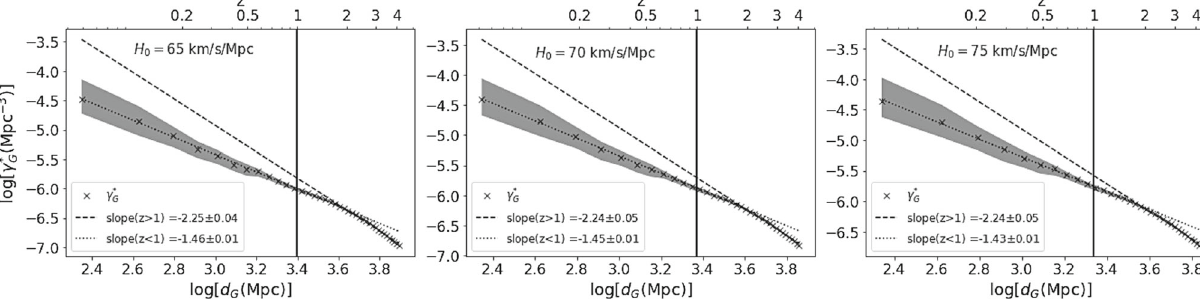
Fig. 6 Log–log graph of γ ∗ vs. d G obtained with the COSMOS2015 galaxy redshift survey dataset in the ranges z < 1 and 1 ≤ z ≤ 4 and G respective distance measures